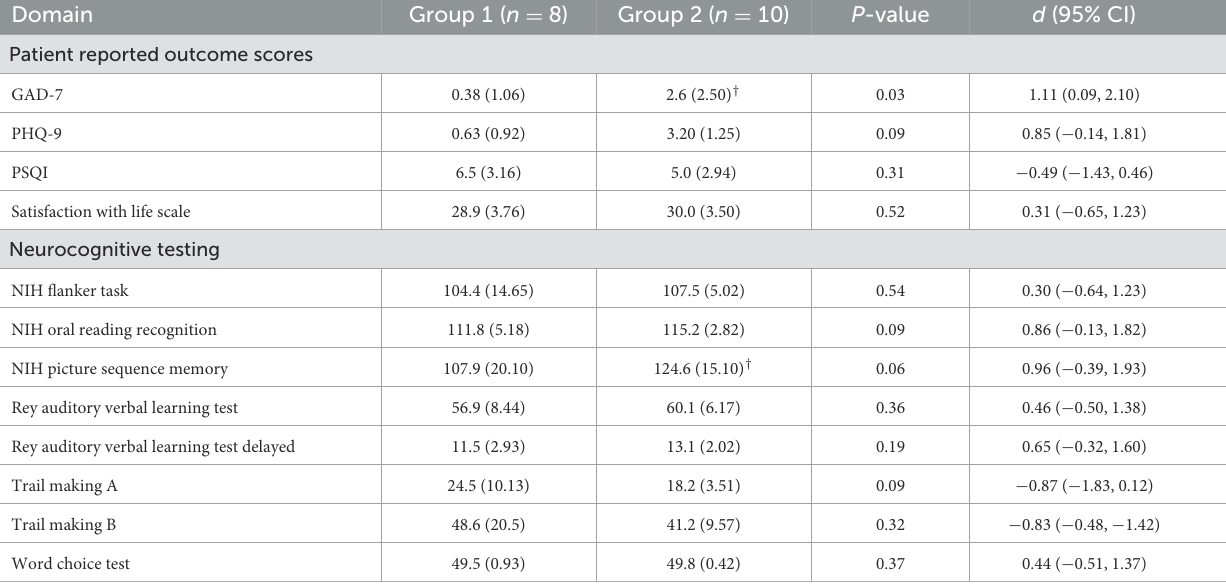
TABLE 2 Descriptive data for patient reported outcome measures and neurocognitive assessments administered at VISIT 3.